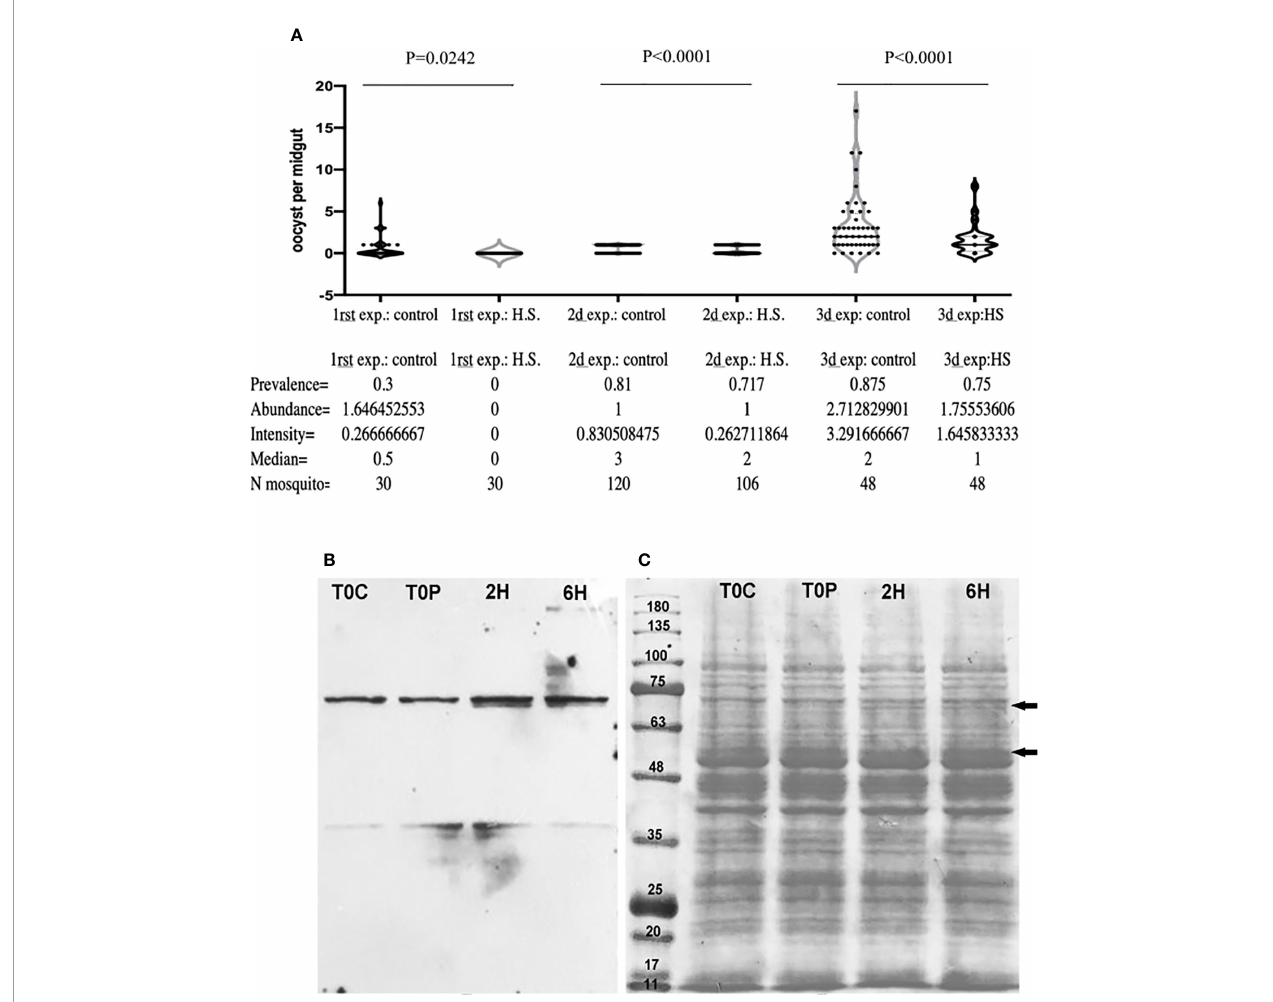
FIGURE 1 | Effect of Heat shock on P. berghei infection in A . albimanus. (A) A. albimanus susceptible strain oocyst infection prevalence expressed as the ratio of infected mosquitoes over total mosquitoes sampled with (0.67 on average) and without previous heat shock (0.77 on average). (B) Western blot using the anti- HSP70 antibody of a 10% acrylamide gel of control 0, 2, and 6 h post-heat shock A. albimanus body protein extracts. (C) Protein pro fi le of the A. albimanus body control T0C (control), T0P (Time zero post heat-shock), 2H (2 h post-heat shock), 6H (6 h post-heat shock). Black arrows indicate differential bands appearing in the ponceau red staining of protein pro fi le of the 2 h post heat shock and 6 h post heat shock